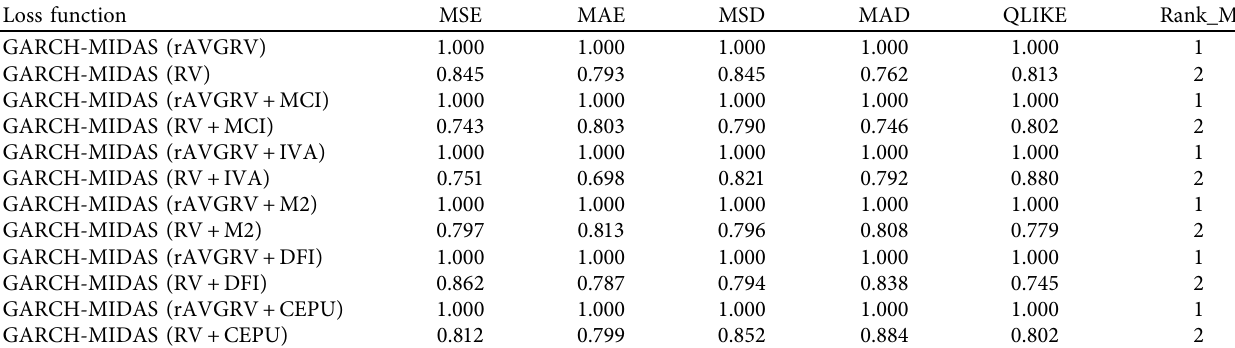
Table 4: The MCS tests of GARCH-MIDAS model.